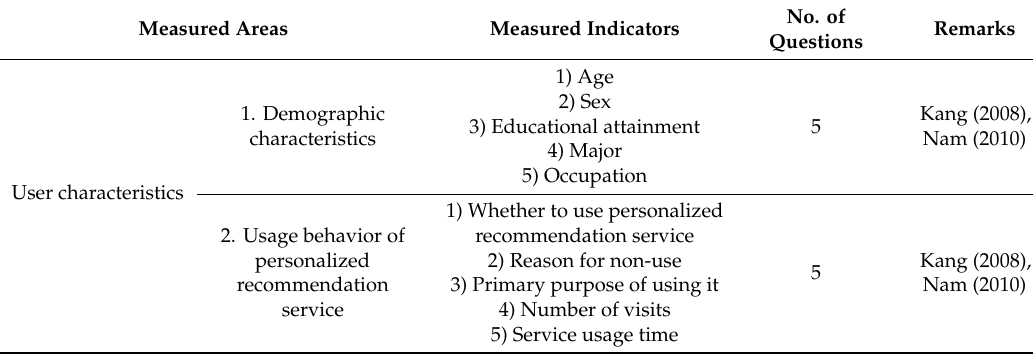
Table 1. Composition of the